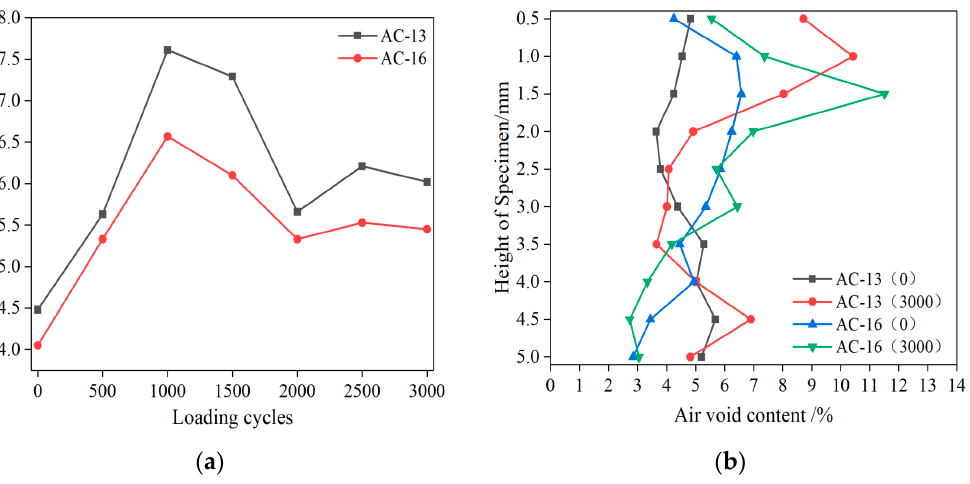
Figure 12. Change of air-void content: ( a ) change with loading cycles; ( b ) along the depth direction.